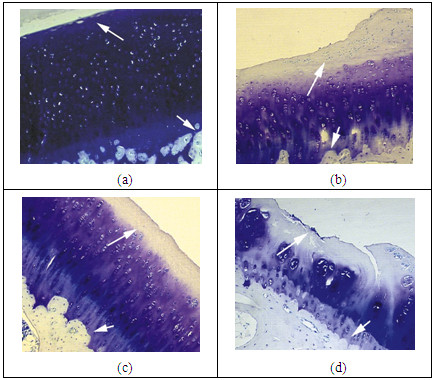
The toluidine blue stained histological sections of (a) normal cartilage, (b) the grade 1 cartilage, (c) the grade 2 cartilage, and (d) the grade 3 cartilage. Matrix staining was homogeneously colored by toluidine blue in (a). The reduction in staining was found in (b-d). The long arrows indicate the superficial zone of articular cartilage. The short arrows show the interface between the bone and the cartilage.